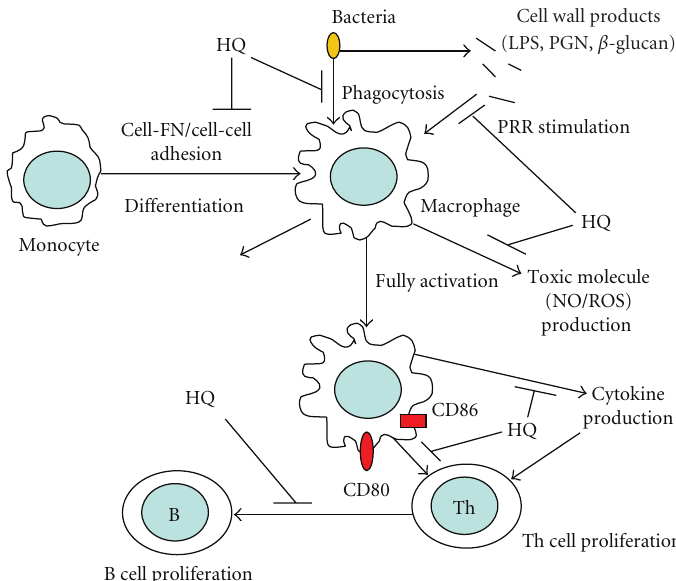
Figure 11: Schematic diagram of hydroquinone-mediated